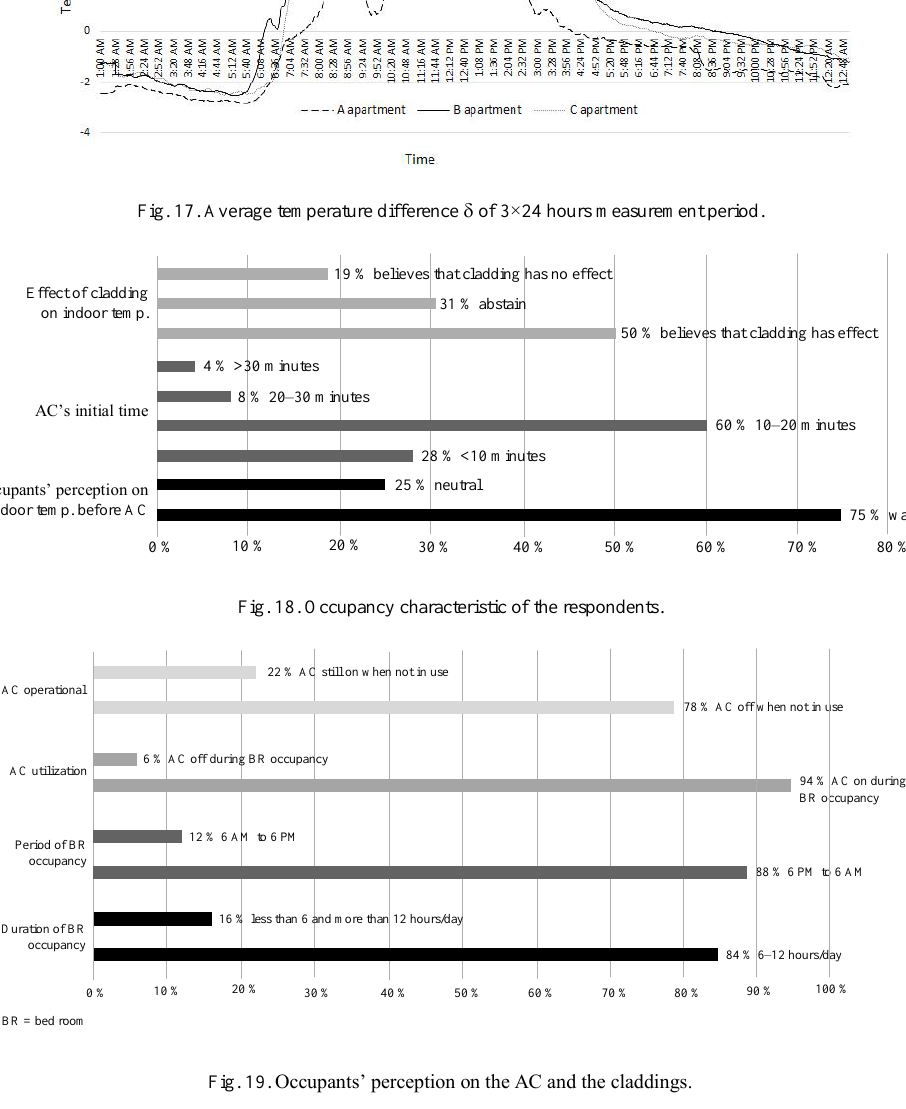
Fig. 19. Occupants’ perception on the AC and the